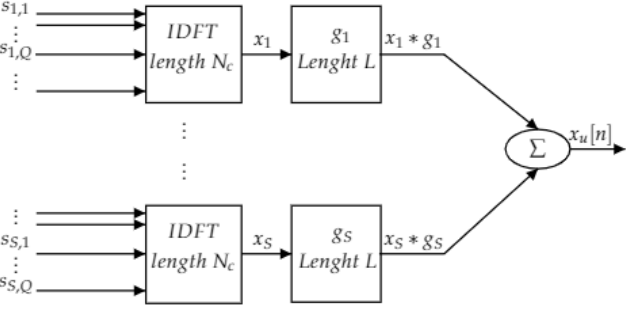
Figure 1. Universal filtered multicarrier (UFMC) transmitter.